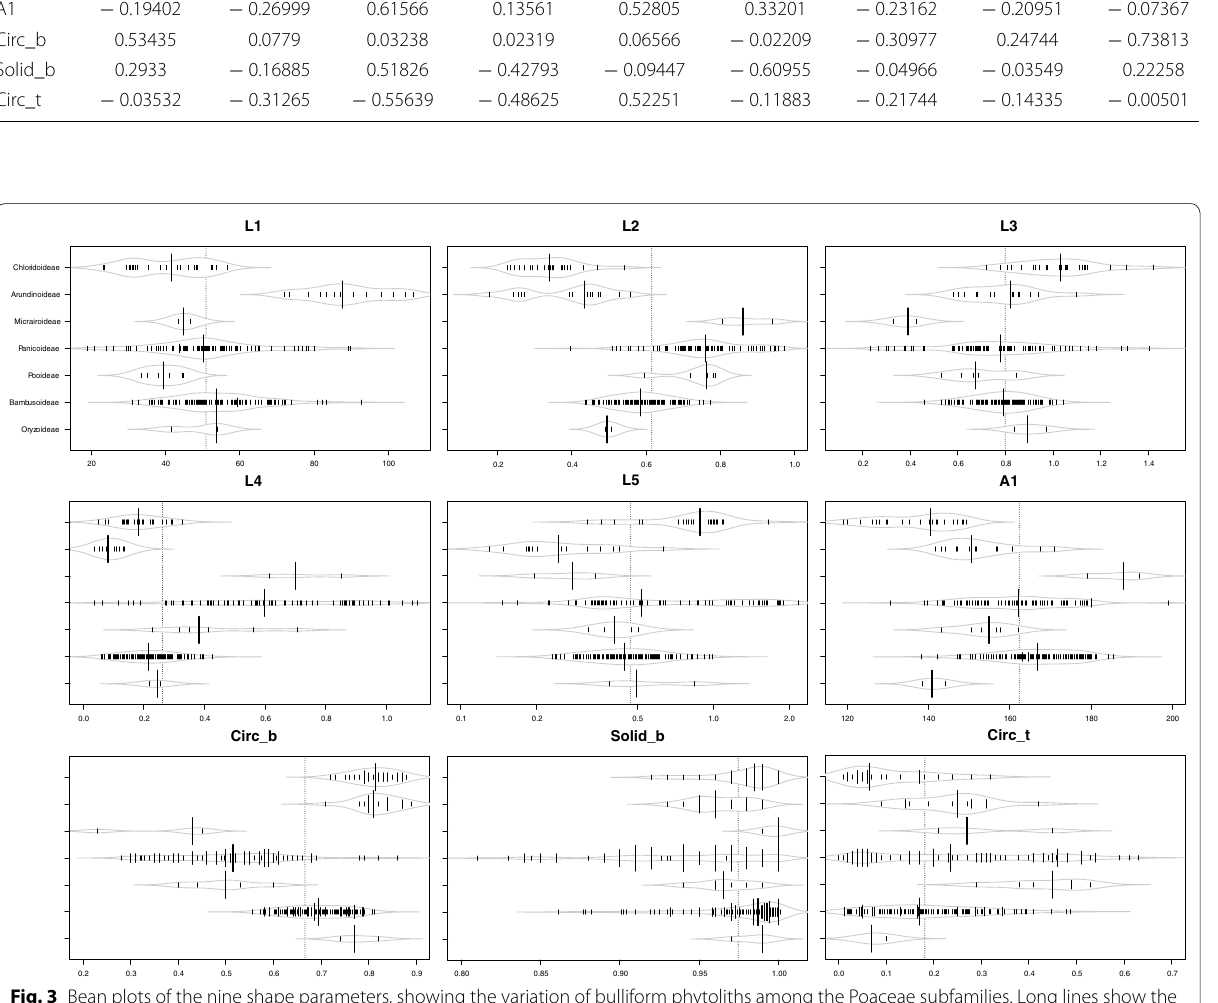
on the leaf adaxial surface; bottom refers to the part adjacent